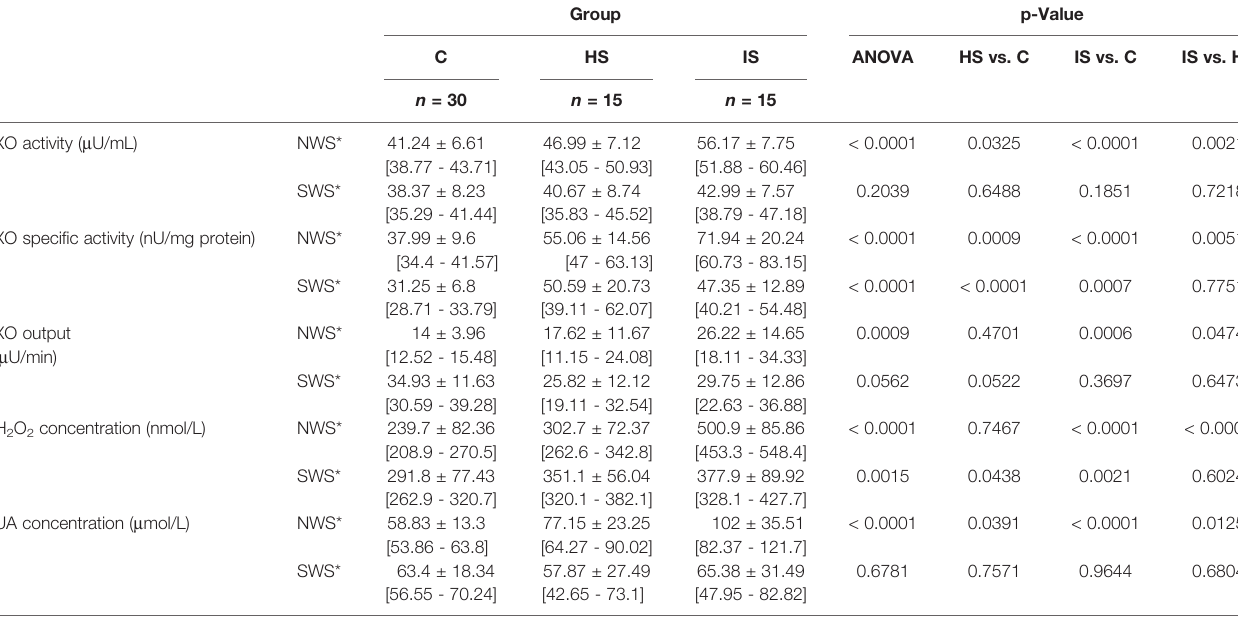
TABLE 4 | Salivary ischemia biomarkers of the studies and control groups. Group p-Value C HS IS ANOVA HS vs. C IS vs. C IS vs.